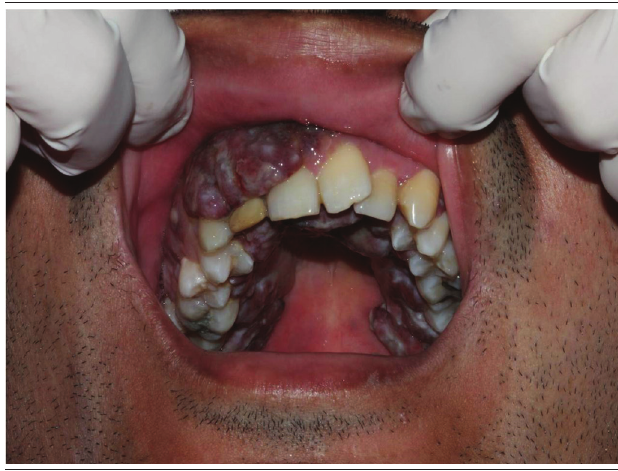
figurE 2 − Initial clinical aspect of the patient’s intraoral lesions before the use of antiretroviral therapy: multinodular, erythroleukoplastic lesions of fibroelastic consistency and bleeding in the palate, in the upper anterior labial ridge, and the right and left inferior retromolar regions